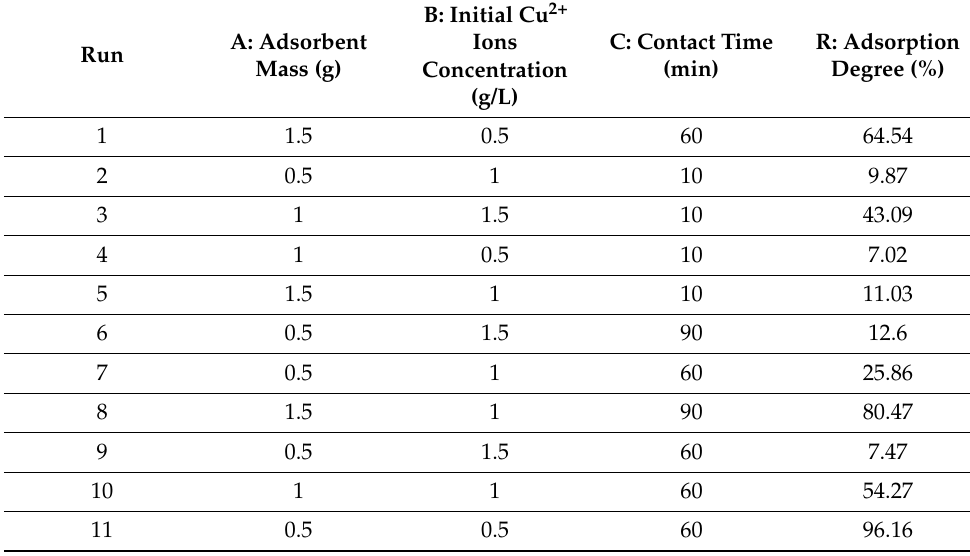
Table 6. Box-Behken Design matrix for three factors along with observed response for Cu 2+ biosorp- tion onto